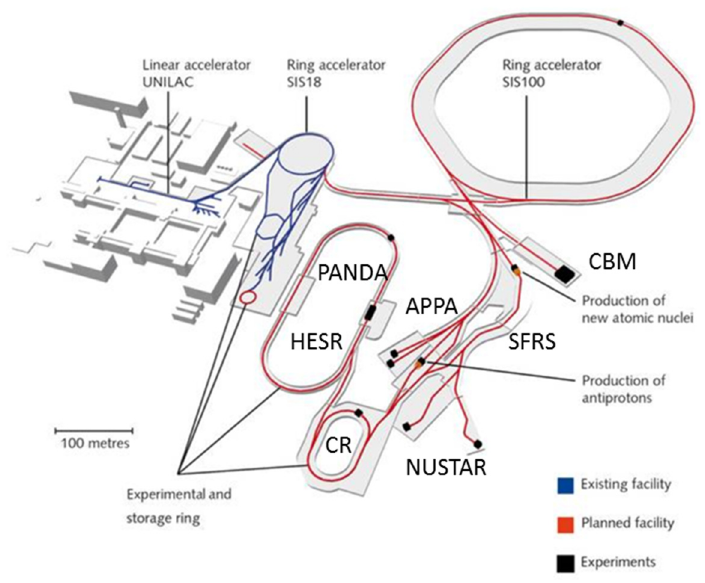
Figure 1. Layout of the Facility for Antiproton and Ion Research (FAIR) (see text) [1,2]. The “Nuclotron-based Ion Collider Facility” (NICA) at the Joint Institute for Nuclear Research (JINR) in Dubna is one of the mega-science projects in Russia [3,4]. At NICA, the new superconducting booster synchrotron accumulates and accelerates the ions for efficient stripping, and then injects the ions into the Nuclotron synchrotron, which finally accelerates the beams up a magnetic rigidity of 45 Tm. For example, Au beams up to kinetic energies of 4.5 A·GeV and with intensities of up to about 10 9 ions/s will be either used for fixed target experiments, or injected into the NICA collider, where collision energies of up to √ s NN = 11 GeV and luminosities of 10 27 cm − 2 s − 1 can be reached. Polarized protons and deuterons will be injected from an ion source directly into the Nuclotron. The layout of NICA is displayed in Figure 2. In the Nuclotron experimental hall, setups with a fixed target are located, for example the Baryonic Matter at Nuclotron (BM@N) experiment. In the collider, two detector stations will be established, the Multiple Purpose Detector (MPD), which will be used for dense matter studies, and the Spin Physics Detector (SPD).